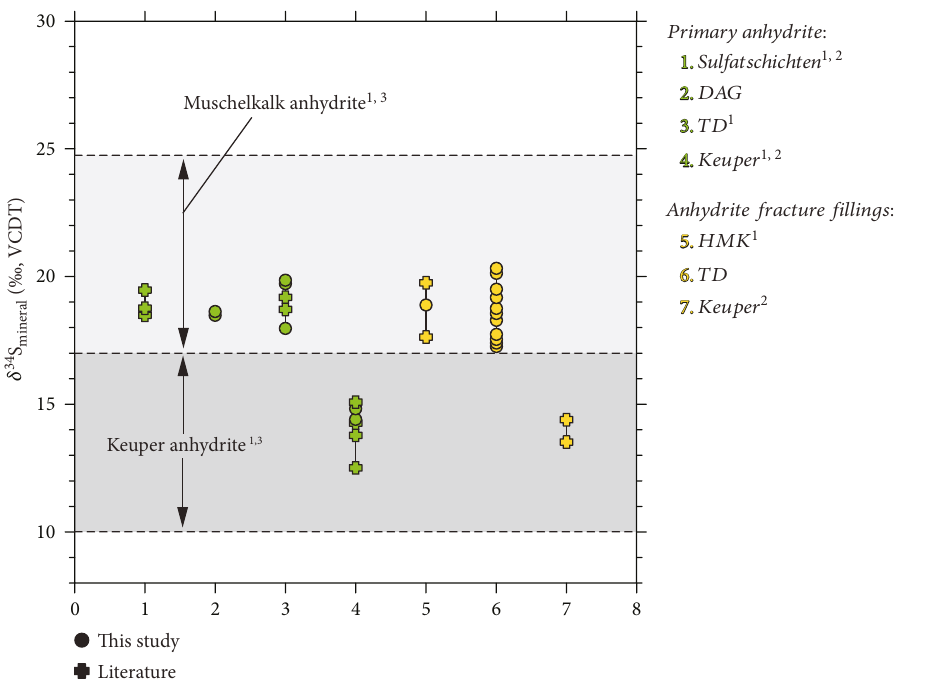
Figure 13: Sulphur isotopic composition of primary anhydrite in the Sulfatschichten (Middle Muschelkalk), the Dolomit der Anhydritgruppe (DAG), the Trigonodus Dolomit (TD), and the Keuper compared to those of secondary anhydrite fracture- fi llings in the Hauptmuschelkalk (HMK), TD, and Keuper. 1 [20], 2 [38], 3